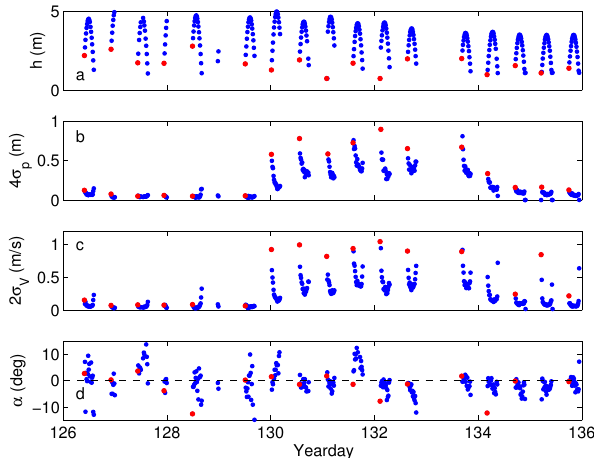
Figure 5. ADV time series: (a) mean water level; (b) significant wave height, 4 σ p ; (c) significant wave orbital velocity, 2 σ v ; (d) wave angle of incidence. The first data points on the rising tide are red.